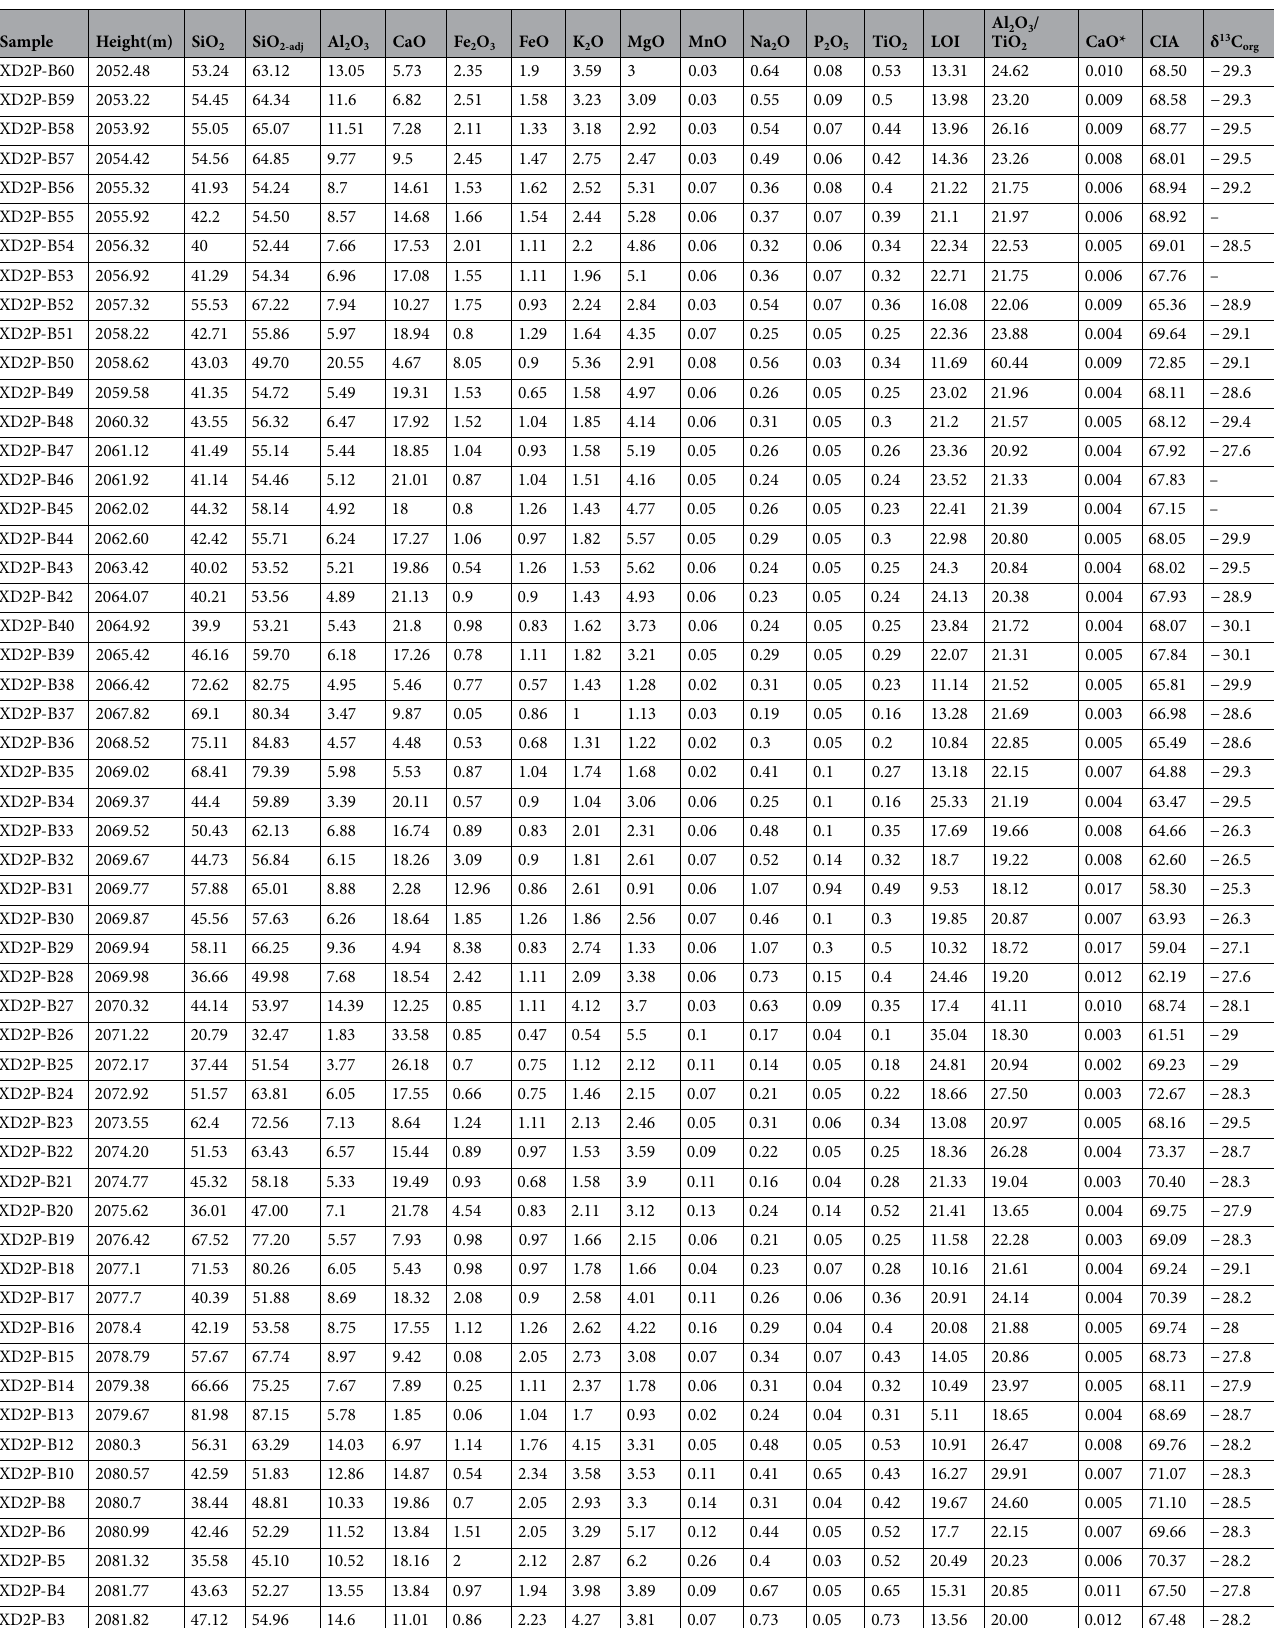
Table 2. Analytical data of major elements (wt%) and organic carbon isotopes (‰) in shales and carbonaceous marls from the Wufeng-Longmaxi formations in the Xindi No. 2